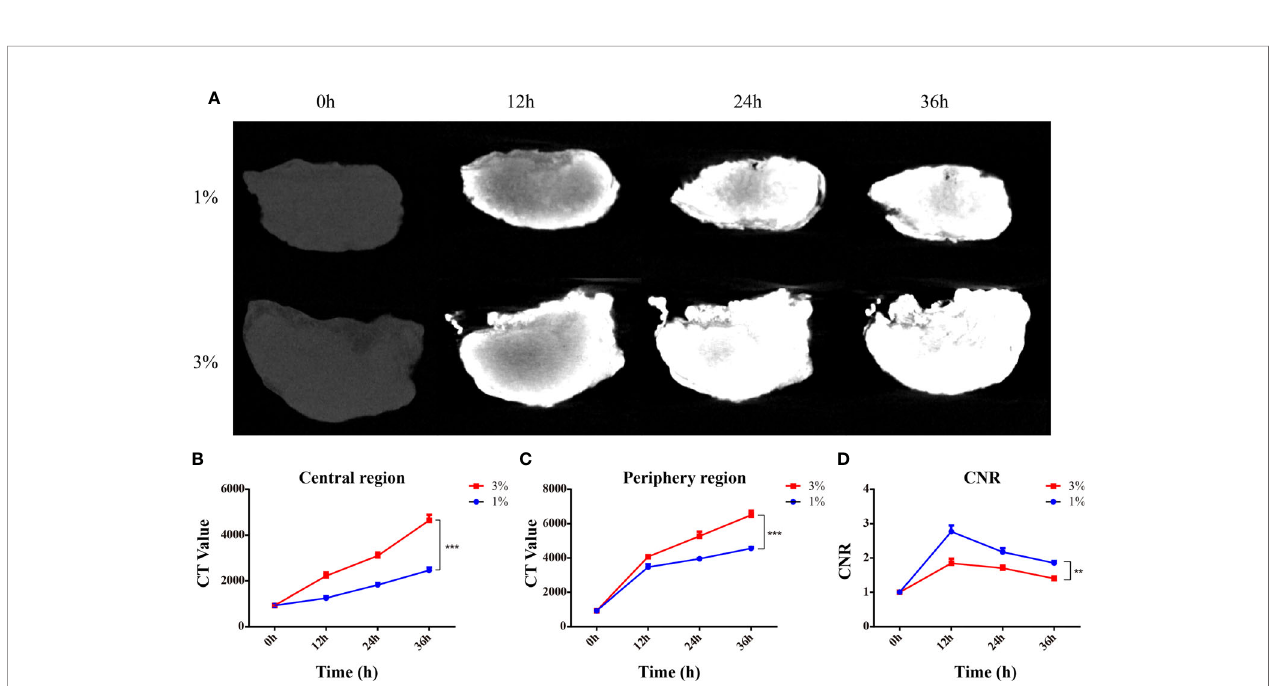
FIGURE 3 | I 2 -IK-enhanced micro-CT imaging for clinical OSCC normal LNs. (A) , Micro-CT image of normal LNs stained with different concentration of I 2 -IK for different time. (B, C) , CT value in the peripheral region and central region of LNs. (D) CNR of LNs stained with different concentrations of I 2 -IK for different times. (**p < 0.01, ***p <